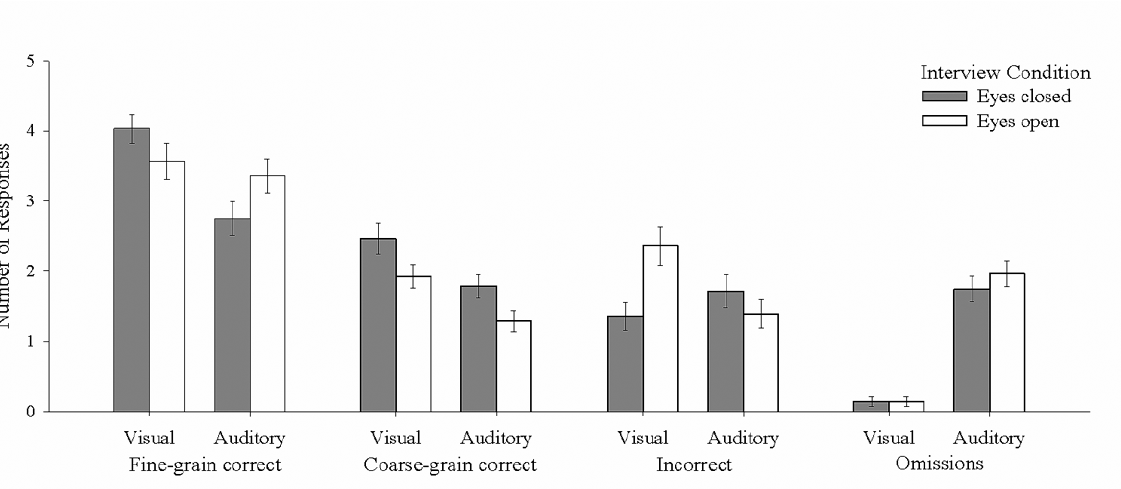
Figure 1. Mean number of fine-grain correct, coarse-grain correct, incorrect, and omitted responses about visual and auditory aspects of the witnessed event in Experiment 1. Error bars indicate standard